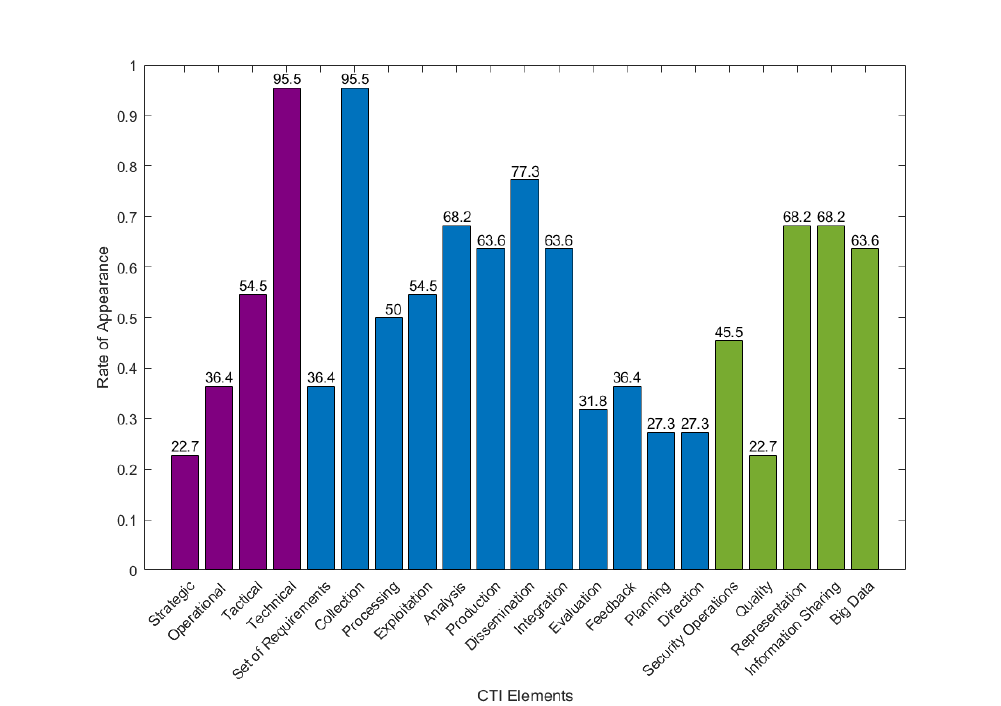
Figure 5. Rate of CTI Elements’ Appearance in existing CTI